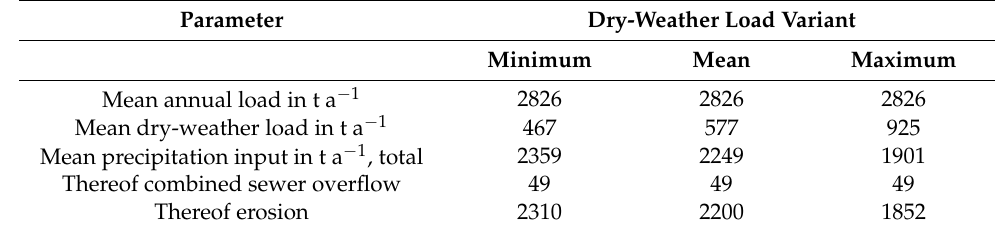
Table 3. Mean annual river loads separated into dry-weather load and precipitation input.